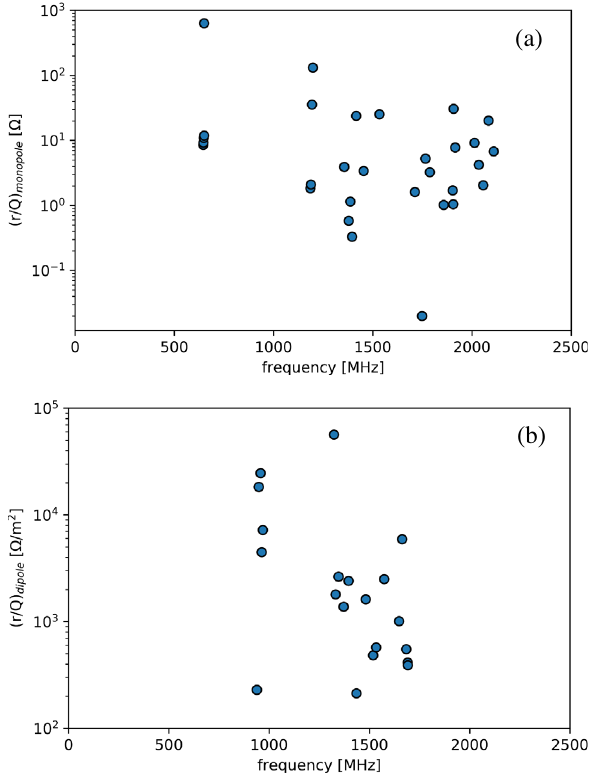
FIG. 13. Impedances of (a) monopole HOMs and (b) dipole HOMs as a function of the mode